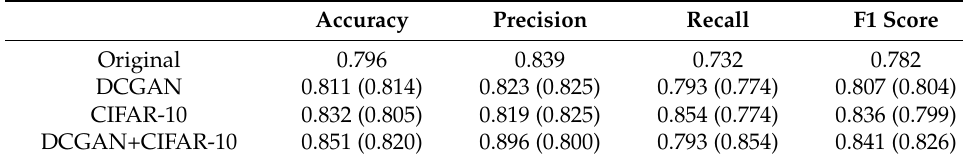
Table 2. Model performance for gastric cancer